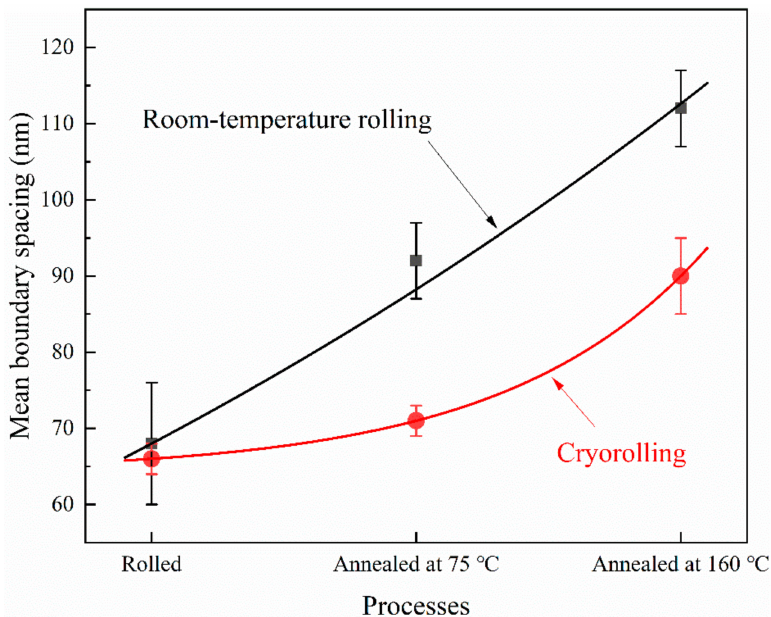
Figure 5. Mean boundary spacing of Ni sheets subjected to different